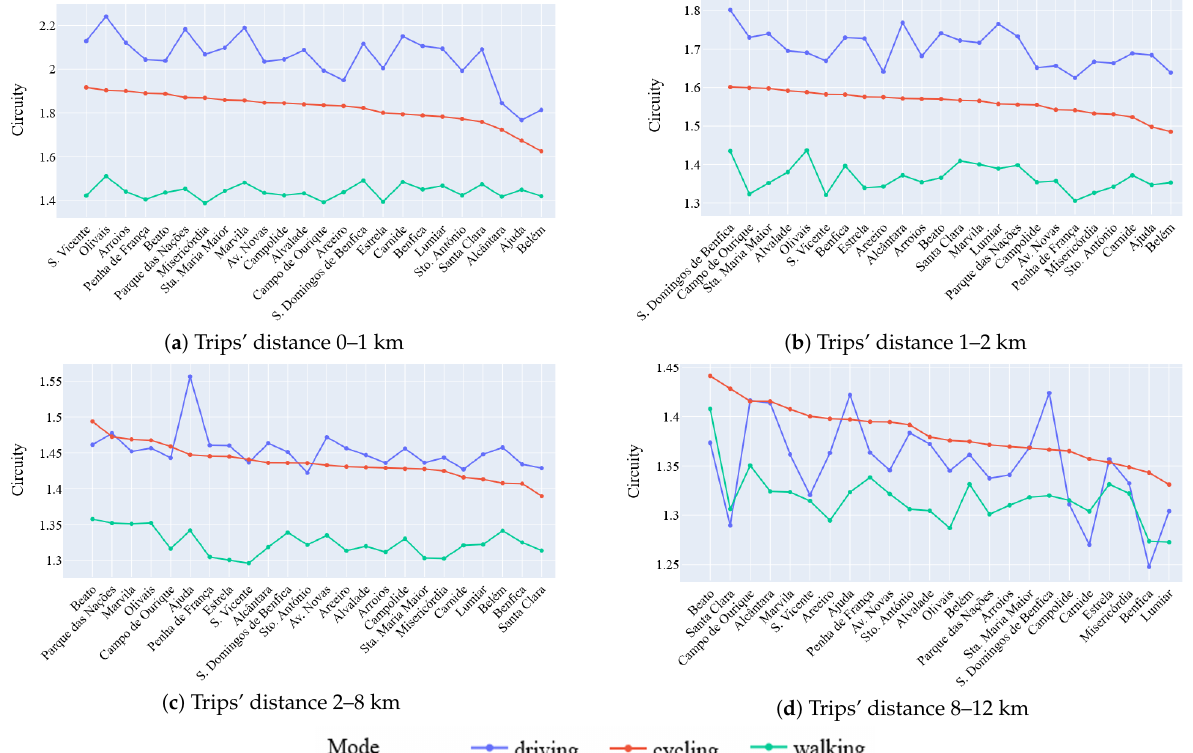
Figure 7. Median in-parish trips circuity for driving, cycling, and walking in 2020 using